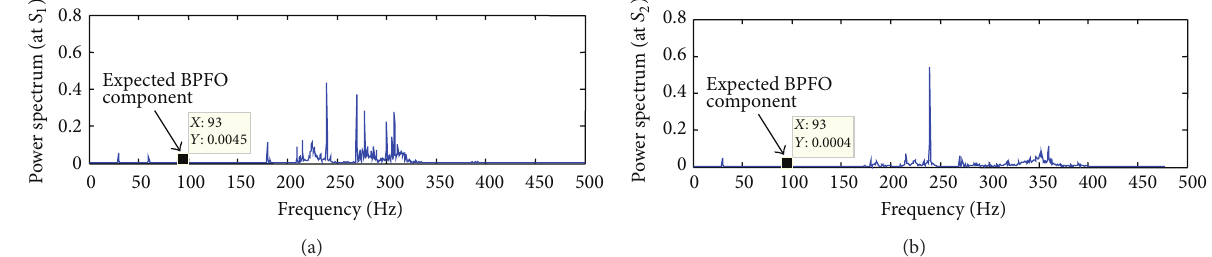
Figure 6: Power spectrums in the case of a fault on the outer race of the ball bearing: (a) measured at 𝑆 1 and (b) measured at 𝑆 2